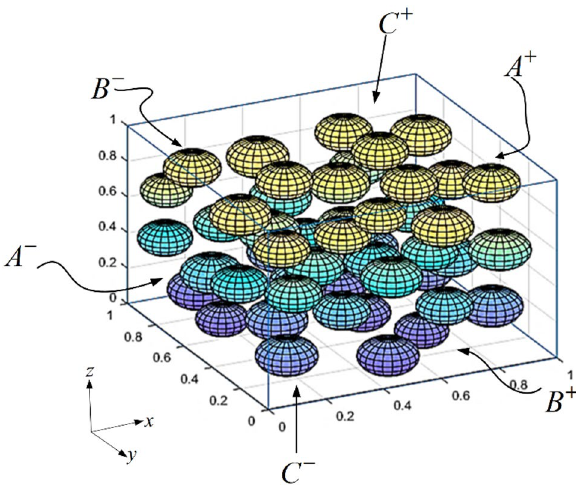
Figure 4. Representative volume element (RVE) containing the piezoelectric